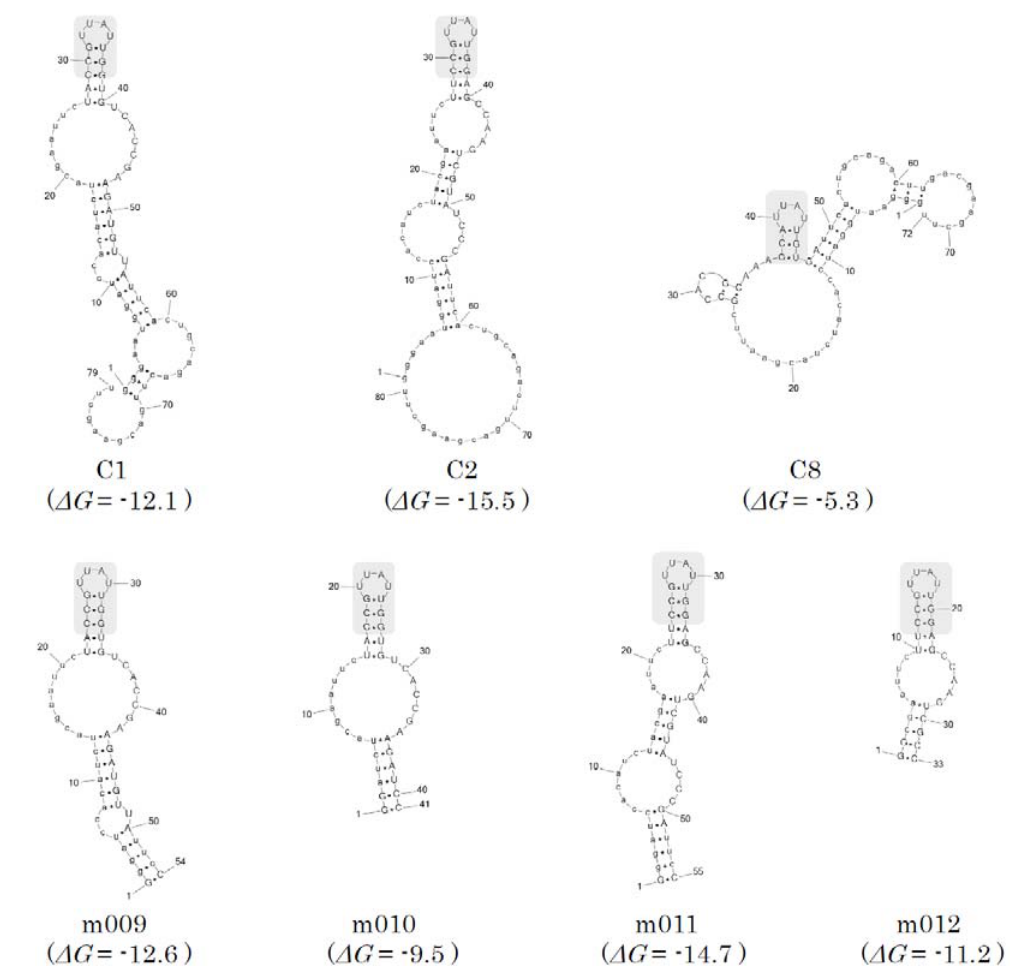
Figure 4. Predicted secondary structures of the SPC aptamers. The estimated stabilities, Δ G (kcal/mol), are shown in parentheses. The conserved hairpin structure is highlighted with gray backgrounds. All RNA structures were visualized using the PseudoViewer 3 program